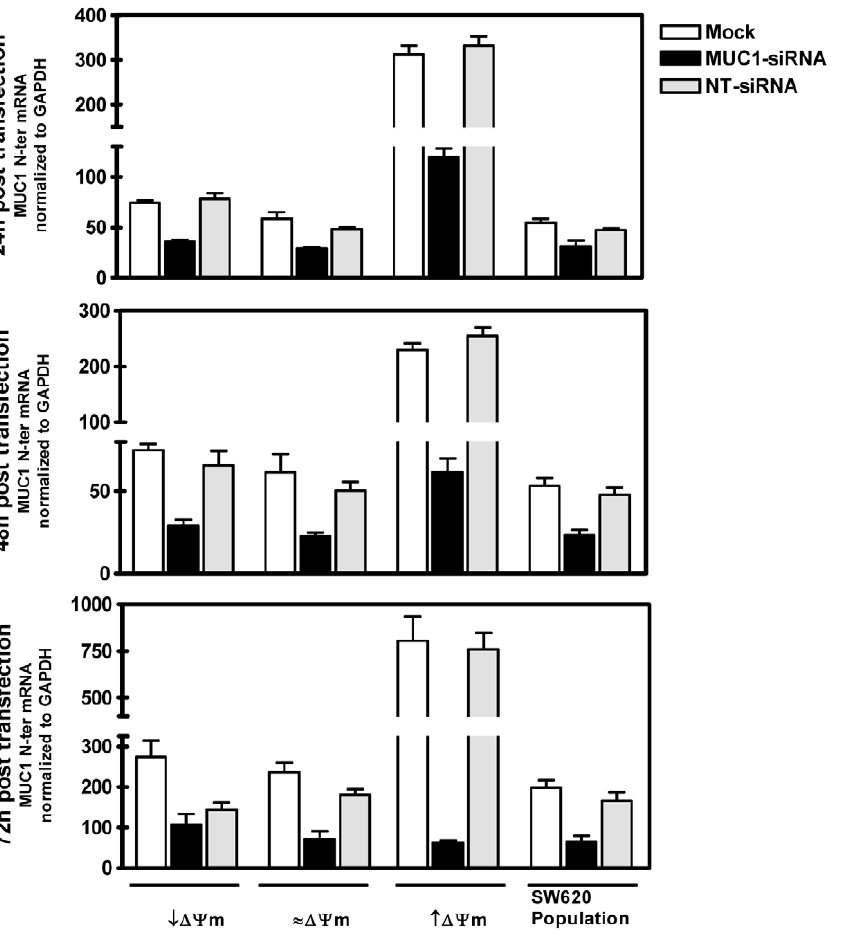
Figure 3. MUC1 siRNA-mediates down regulation of MUC1 expression in subcloned cell lines with different intrinsic Dy m. Subcloned cell lines with intrinsic Dy m higher ( q Dy m), lower ( Q Dy m) and comparable ( < Dy m) to that of the population, and the SW620 parental population, were mock transfected, or transfected with NT- or MUC1-siRNA. Twenty-four, 48 and 72 hours later levels of MUC1 mRNA were determined by qRT- PCR, normalized to GAPDH. The level of MUC1 mRNA in the siRNA-MUC1 transfected cell line with q Dy m did not differ significantly from that of mock transfected SW620 cell population 48 and 72 hours after transfection ( P . 0.05).